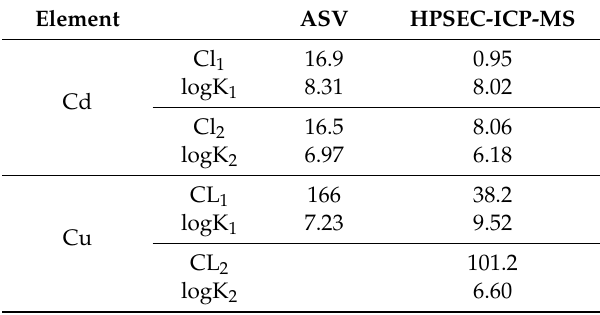
Table 1. Concentration in nmol / L, Cl s , and corresponding LogK s for the classes of ligands estimated for Cd and Cu, respectively, on the sample of HA 20 mg / L, extract from soil; values obtained via data elaboration obtained from titration followed by anodic stripping voltammetry (ASV) and HPSEC-ICP-MS, respectively.